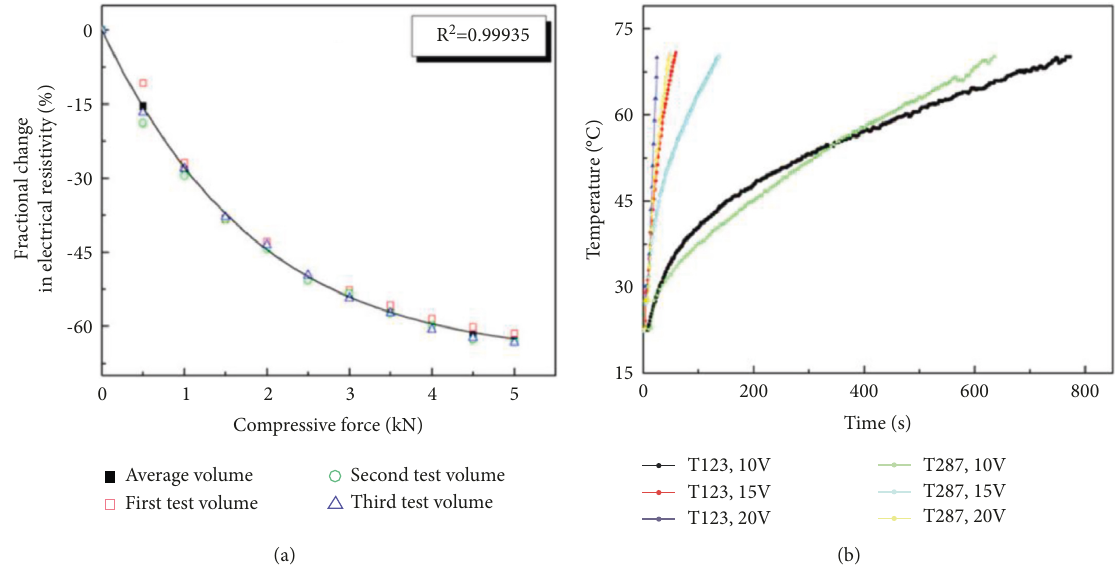
Figure 18: (a) Relationship between compressive force and resistivity of smart Ni-NFC [100]. (b) Temperature-time curve of smart Ni-NFC during heating with different input voltages [101].